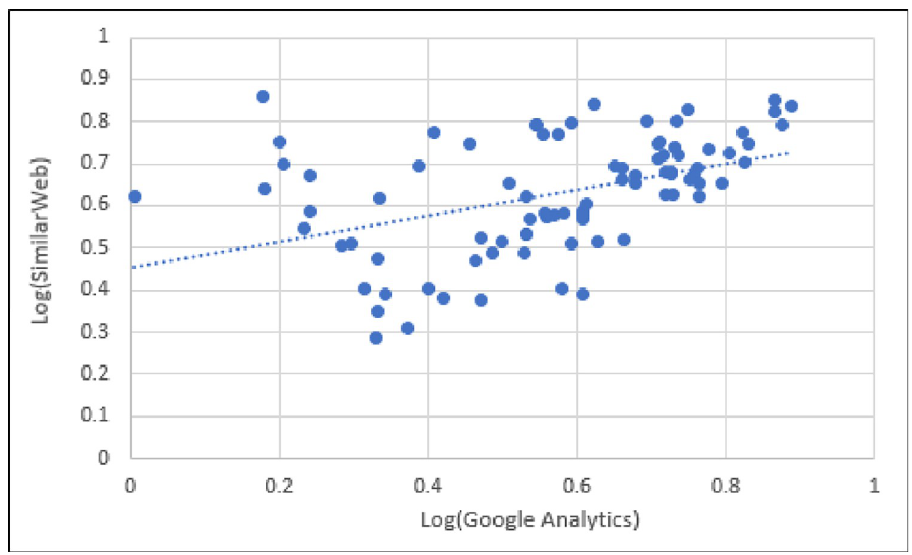
Fig 4. Scatter plot of bounce rate reported by Google Analytics and SimilarWeb showing moderate, positive, linear correlation.